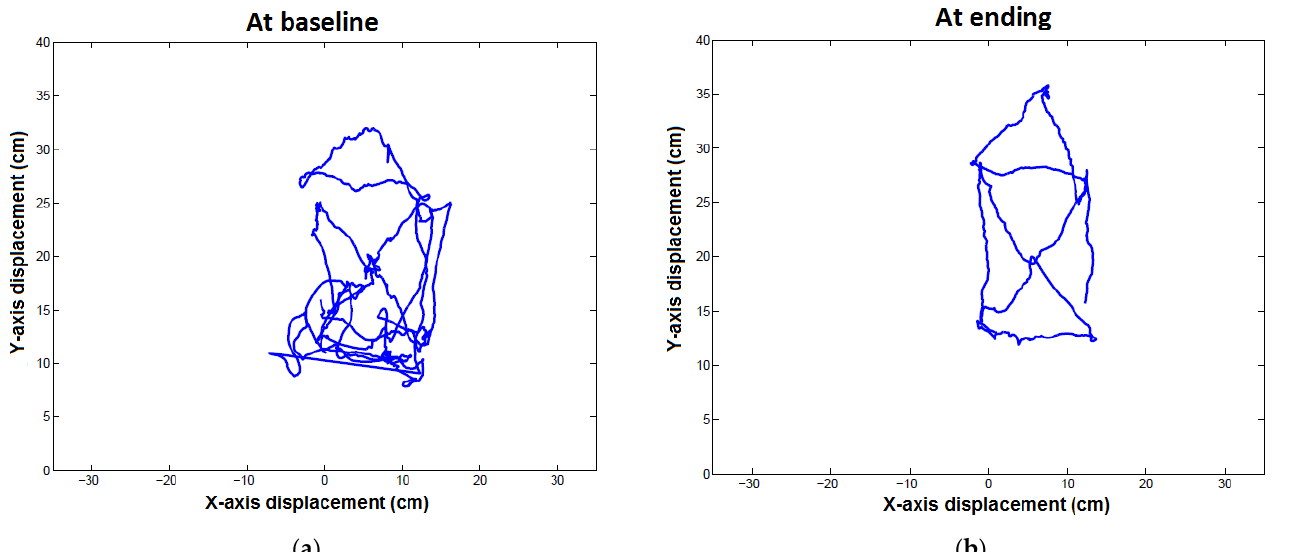
Figure 7. Hand path during the performance of the virtual application Explorer for a patient: ( a ) at baseline condition; ( b ) at ending the upper extremity training.